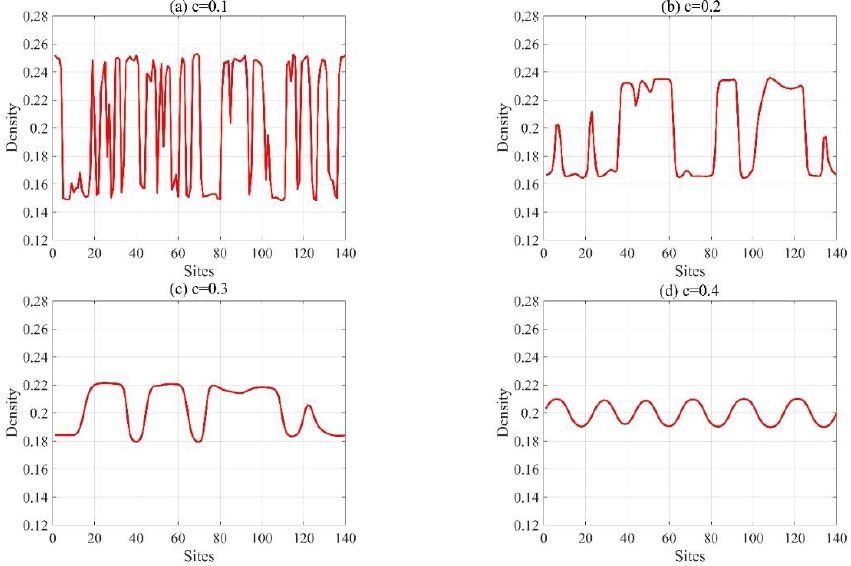
Figure 4, namely the instantaneous traffic flow distribution on each lattice at t = 10,300 s.